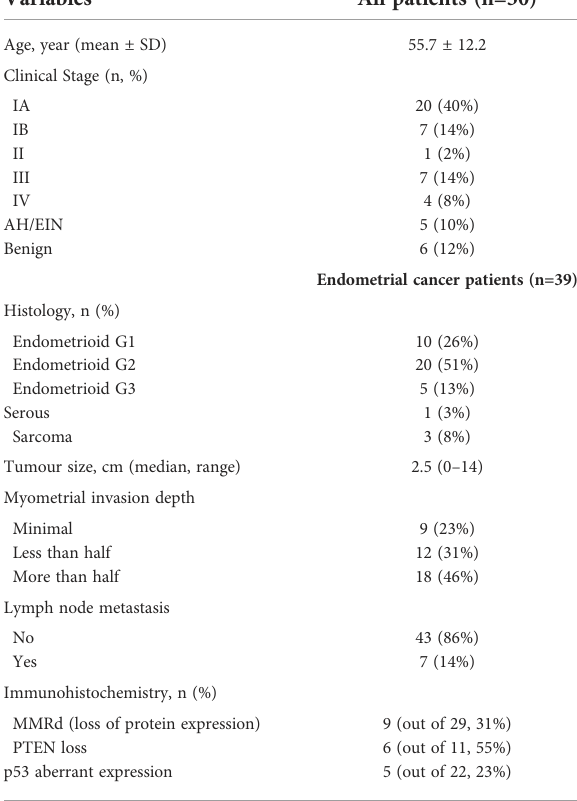
TABLE 1 Distribution of clinical variables among patients with endometrial cancer.